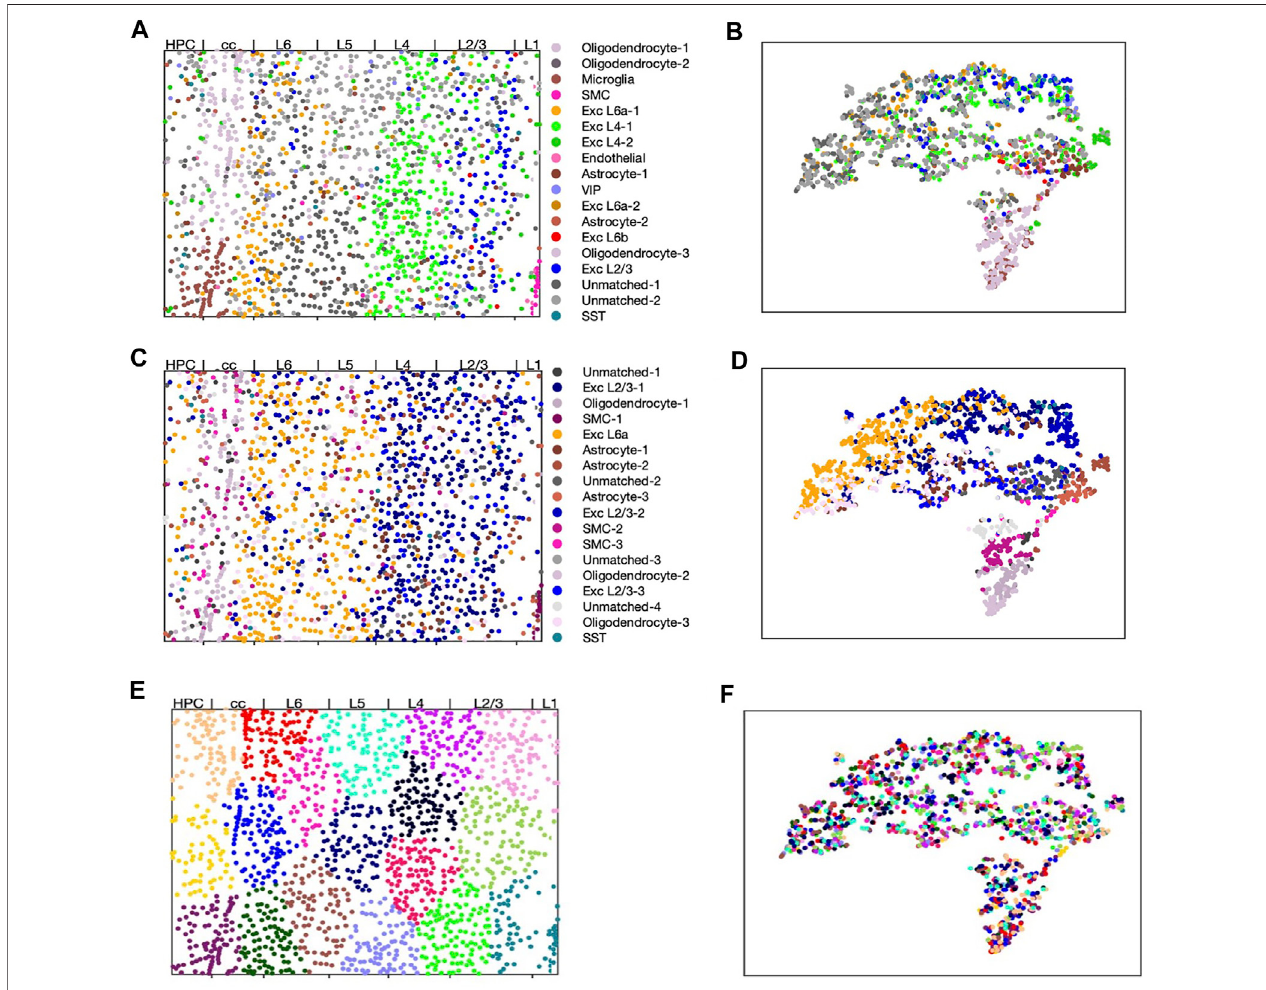
FIGURE3| scHybridNMF,sparseNMFandk-meansclusteringonSTARmapdata.ThelayersarelabelledbyWangetal.(2018). (A,C,E) Visualizingcellsinspacial location with cell cluster labels from respectively scHybridNMF, sparse NMF and k-means. (B,D,F) cells shown in t-SNE plots of gene expression colored with cluster labels from respectively scHybridNMF, sparse NMF and